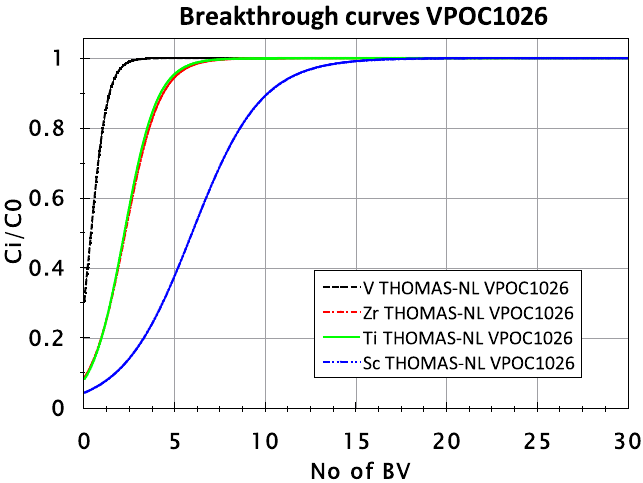
Figure 4. The comparative breakthrough curve for the metals of interest for VP OC 1026 resin according to Thomas nonlinear (NL) prediction mathematical model.